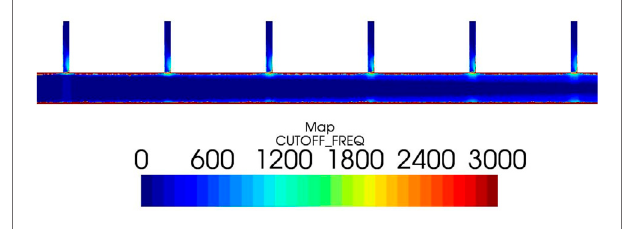
FIGURE 12 | Cut-off frequency map of multiple valves.